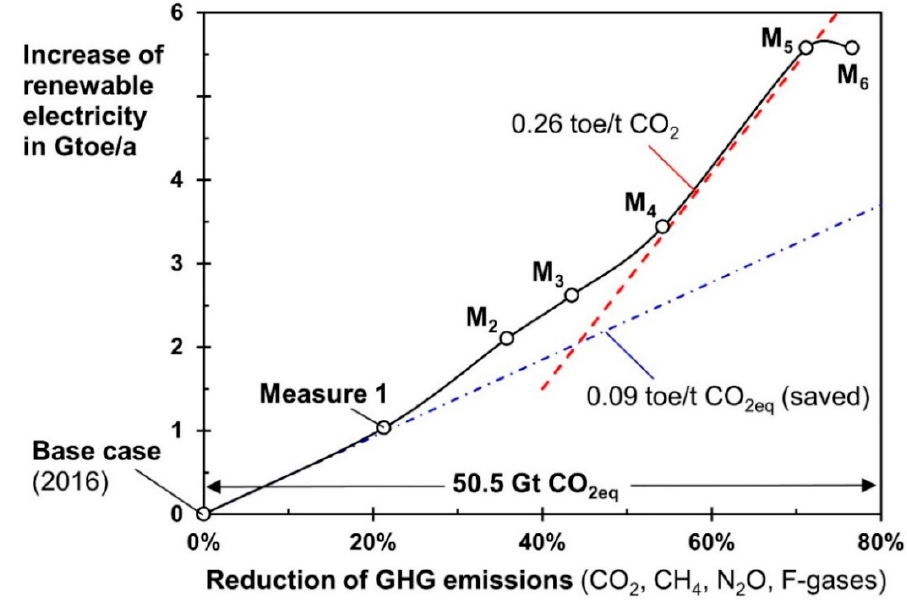
Figure 8. Reduction of global GHG emissions and corresponding increase of annual (renewable) electricity production if measures 1 to 6 are consecutively taken (constant global population and prosperity); for details see also Tables S14 and S15.